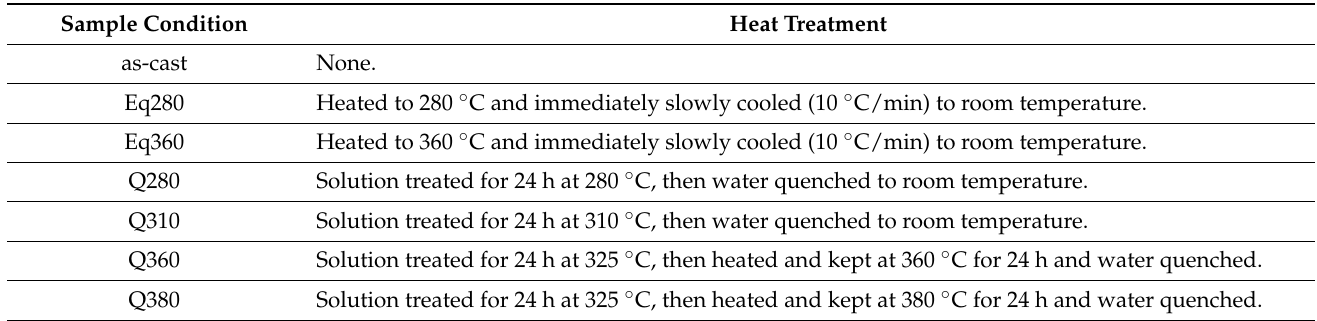
Table 2. Heat treatments for each sample condition. The two-step solution treatment in Q360 and Q380 was applied to prevent any partial melting during one-step solution treatment at the solution